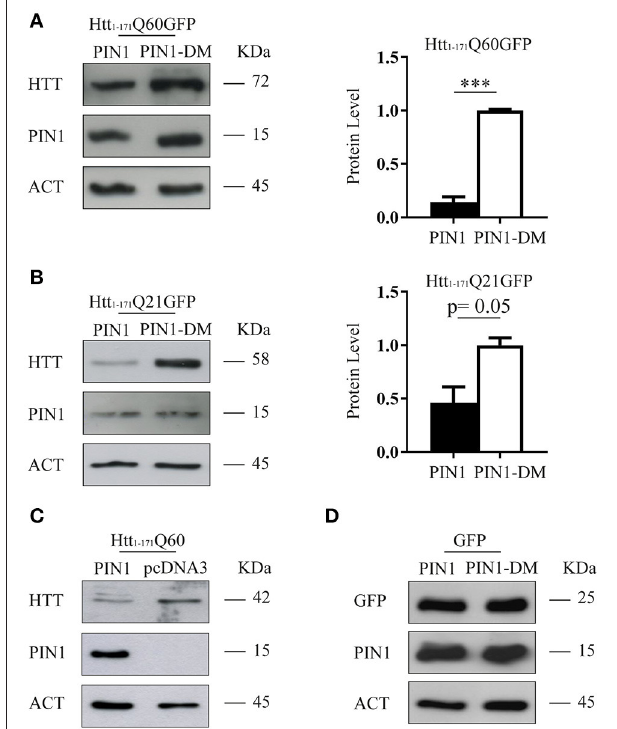
FIGURE 3 | PIN1 overexpression reduces huntingtin protein levels. HEK293 cells were co-transfected with HTT-encoding or GFP-encoding plasmids and HA-PIN1 or HA-PIN1DM. Cells were harvested for analysis 48h after transfection. (A) Representative western blot and corresponding protein quantification showing htt 1 – 171 Q60GFP, PIN1, and β -ACTIN as loading control. (B) Representative western blot and corresponding protein quantification showing htt 1 – 171 Q21GFP, PIN1, and β -ACTIN as loading control. (C) Representative western blot showing htt 1 – 171 Q60, PIN1, and β -ACTIN as loading control. (D) Representative western blot showing GFP, PIN1, and β -ACTIN as loading control. Data are the mean ± SD from 3 independent experiments. *** P < 0.001. Asterisk indicates the statistically significant difference in the level of